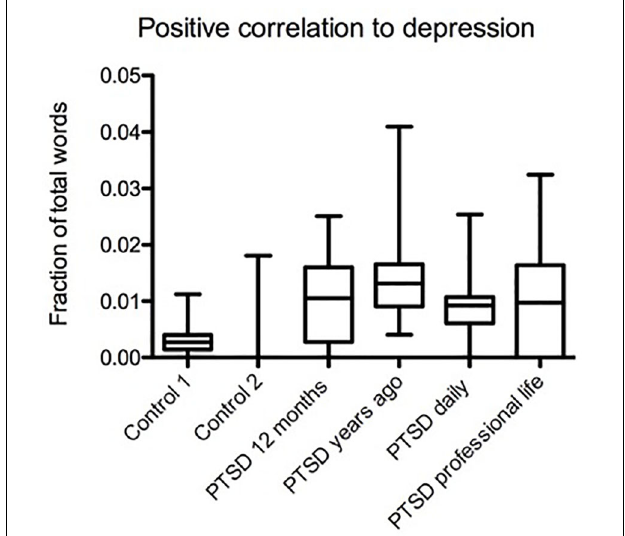
FIGURE 4 | Variable language-based positive correlation between depression and PTSD in different groups. The highest usage frequency of depression-correlated words was in PTSD sufferers who experienced trauma years ago, the difference being statistically significant compared to control 1, but not control 2 (Mdiff = 0.011, Mdiff = 0.007, p < 0.001, p > 0.05). The second highest usage frequency of depression-correlated words was in the PTSD group with professional life related trauma (Mdiff = 0.007, Mdiff = 0.008, p > 0.05, p < 0.05). Daily narratives of PTSD sufferers had more depression-correlated words than daily narratives of control 2, a general population sample (Mdiff = 0.0077, p > 0.05).